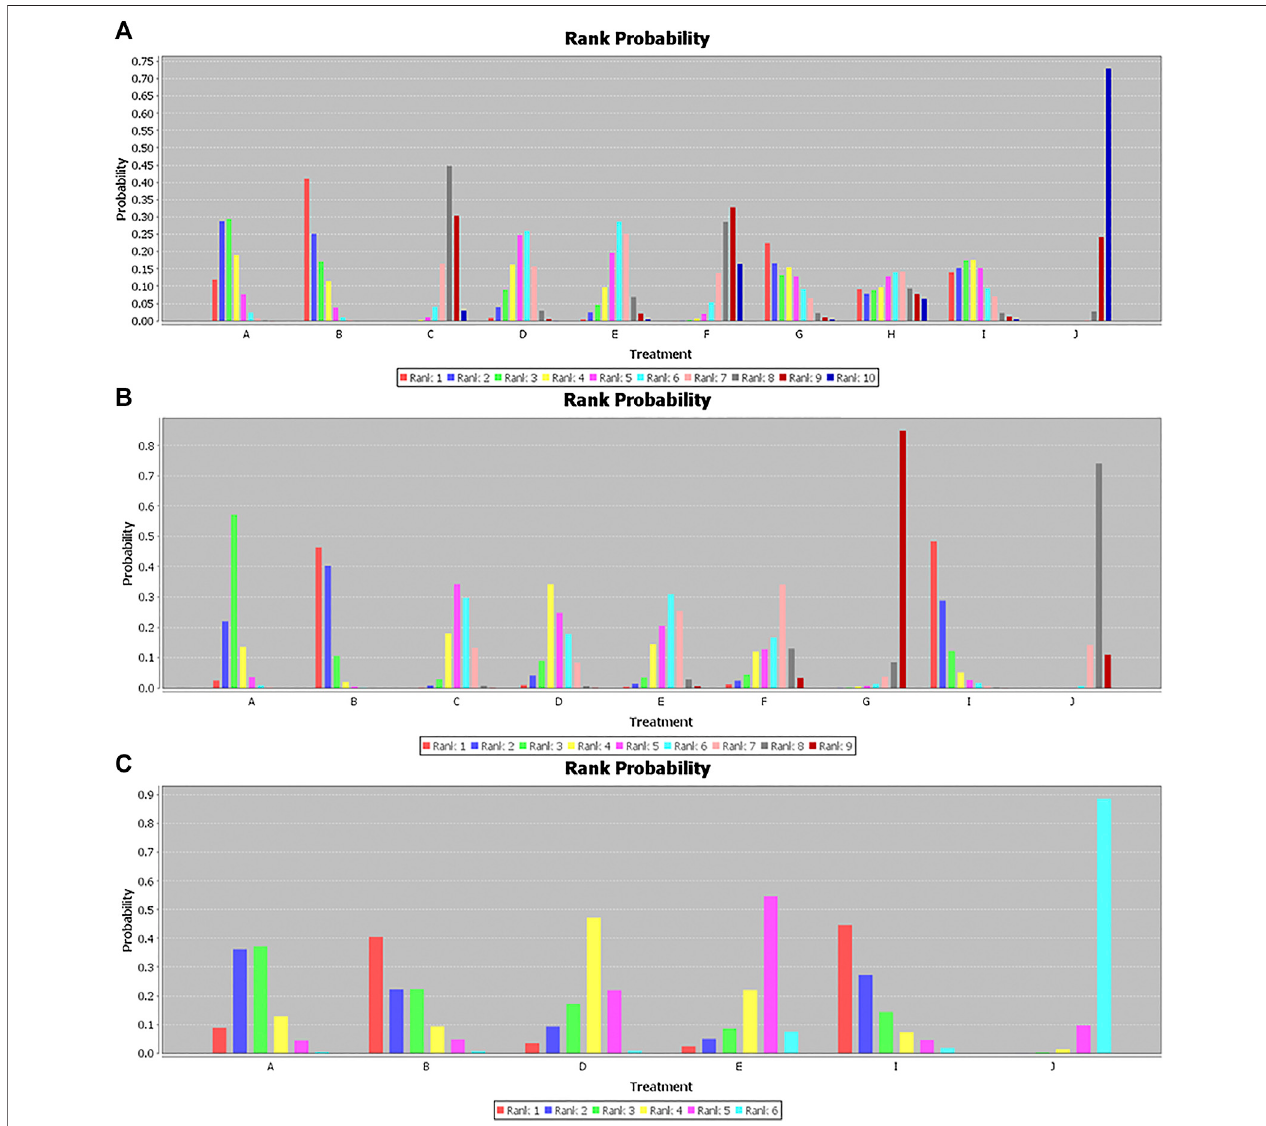
FIGURE2| Rankprobabilityfor (A) inductionofremission. (B) Maintenanceofremission. (C) Steroid-freeremission.A,In fl iximab;B,Adalimumab;C,Certolizumab pegol; D, Vedolizumab; E, Ustekinumab; F, Tofacitinib; G, Filgotinib; H, Upadacitinib; I, CT-P13; J, Placebo.